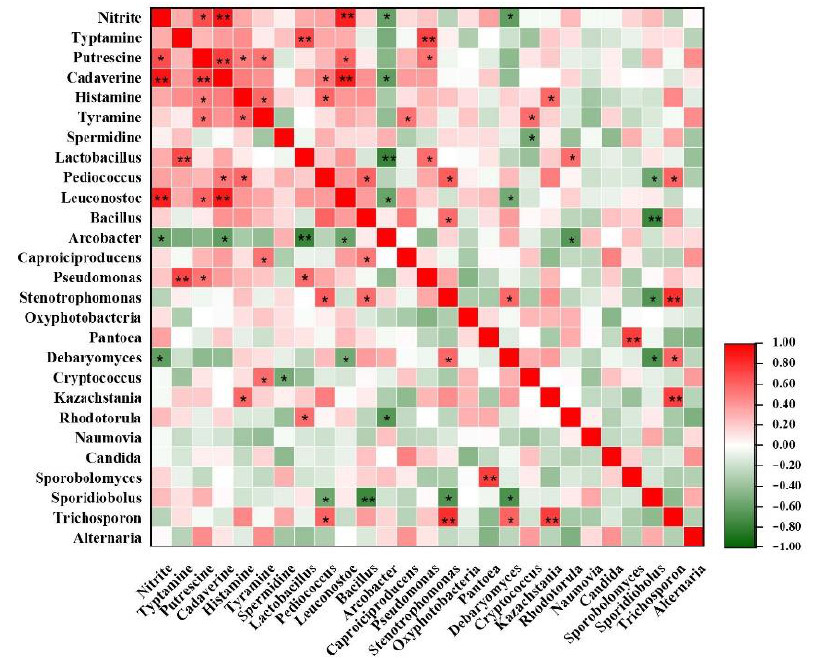
Figure 4. Heatmap of correlations among biogenic amines (BAs), nitrate microbial community and in FM samples. The red and green colors represent positive (0 < r < 1) and negative ( − 1 < r < 0) correlation, respectively. *, p < 0.05; **, p < 0.01.